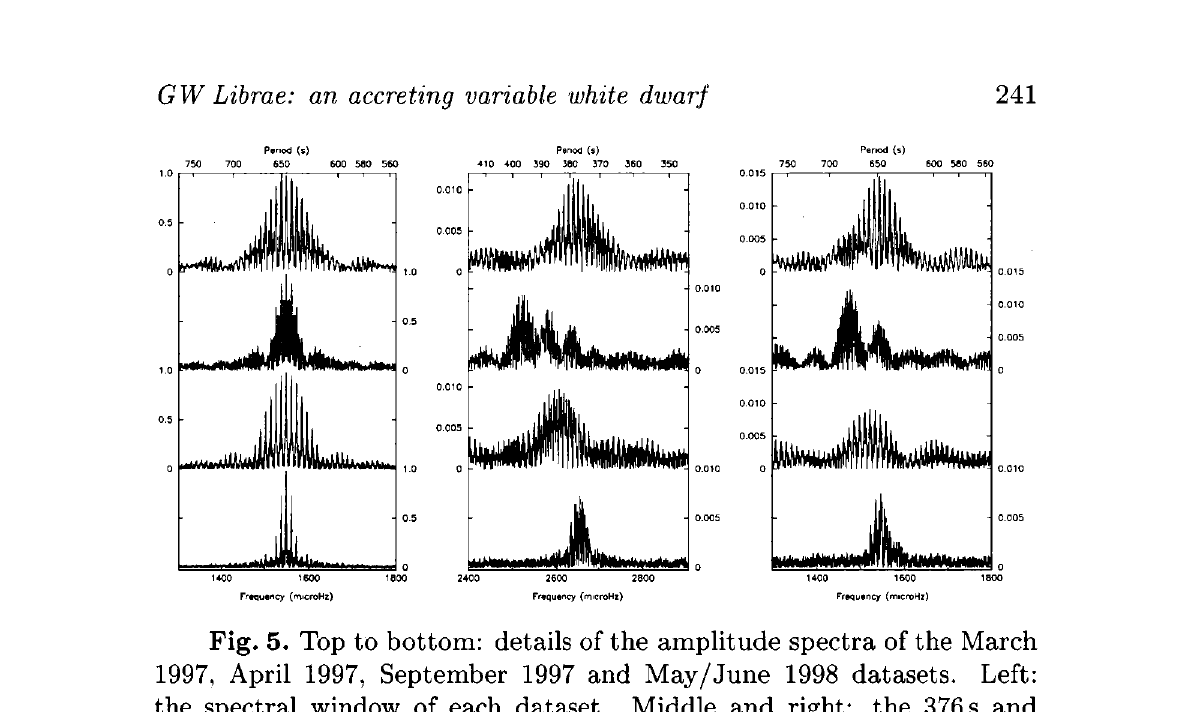
Fig. 5. Top to bottom: details of the amplitude spectra of the March 1997, April 1997, September 1997 and May/June 1998 datasets. Left: the spectral window of each dataset. Middle and right: the 376 s